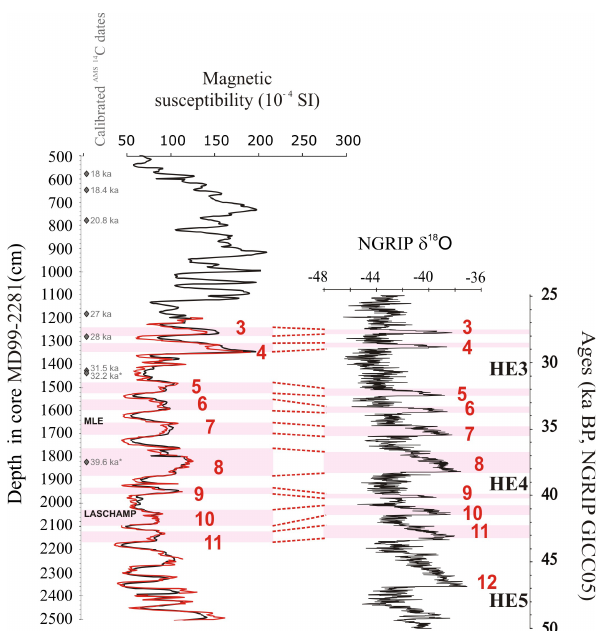
Fig. 3. Magnetic susceptibility (MS) record from core MD99-2281 (dark line=onboard data versus red line=low field magnetic sus- ceptibility) and its correlation to the NGRIP GICC05 δ 18 O record (Svensson et al., 2008) to define supplementary age control-points over the MIS3 period. See also Table 1. Pink bars underline GIs, labels and limits after Wolff et al. (2010). The horizons having recorded the geomagnetic excursions (MLE for Mono Lake excur- sion and Laschamp) are also indicated.